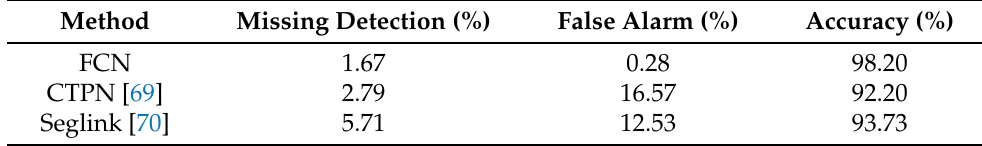
Table 2. Performance of the FCN detection